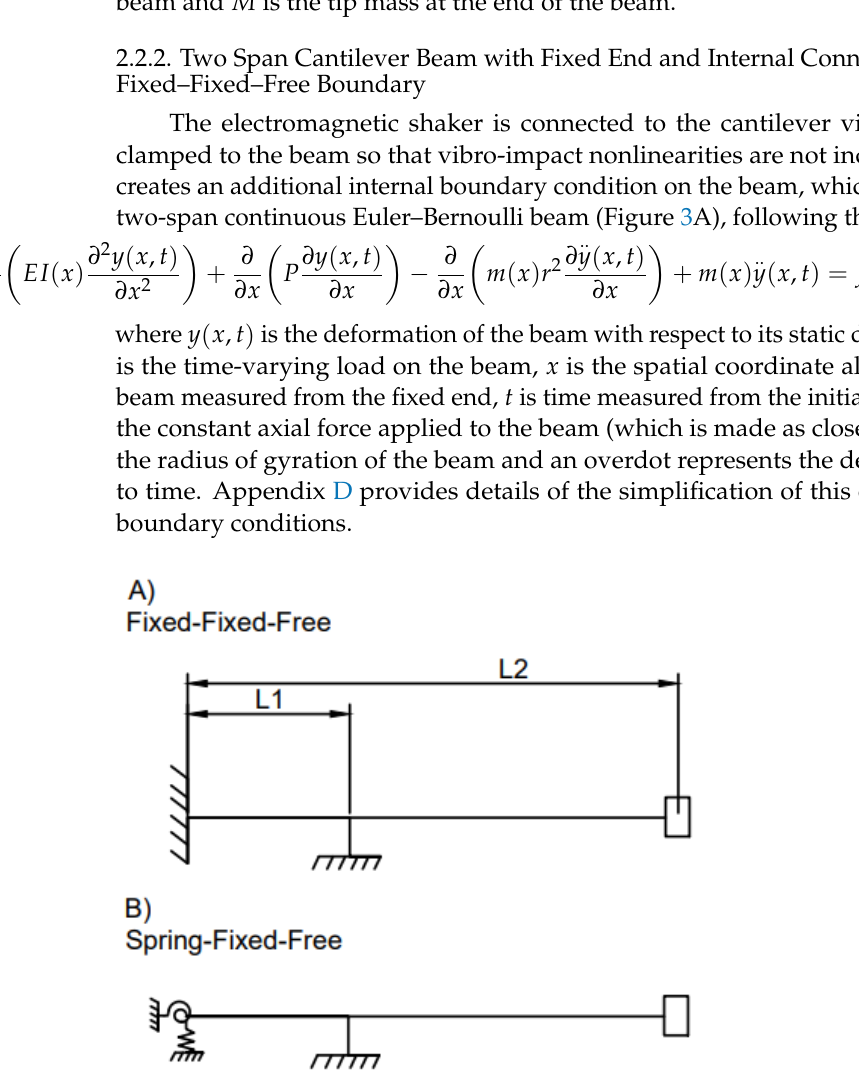
Figure 3. Two span continuous cantilever beams: ( A ) Fixed–fixed–free, ( B ) Spring–fixed–free.